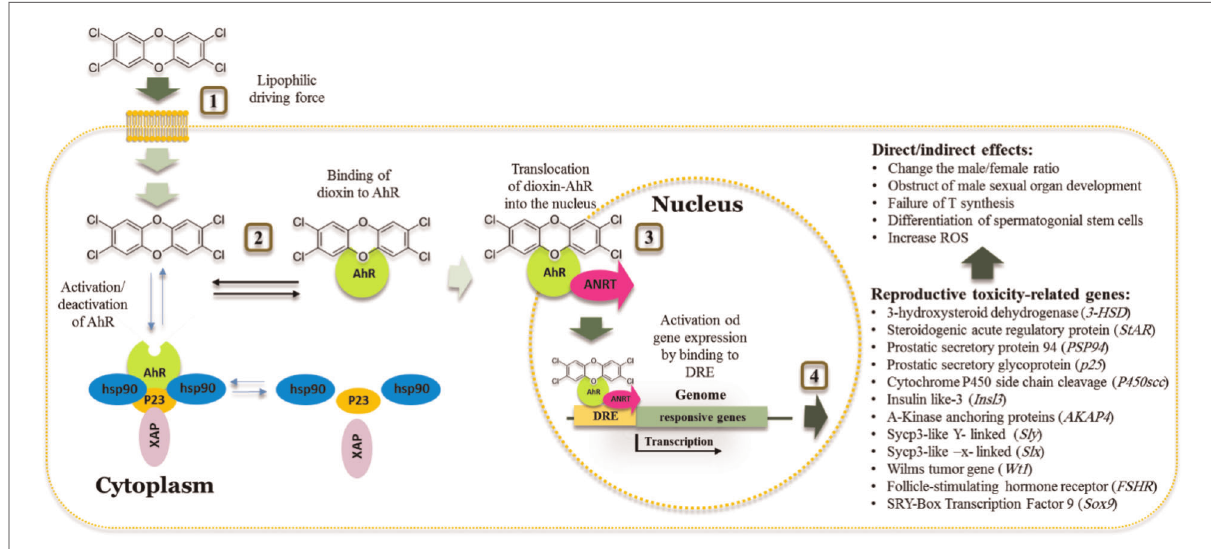
FIGURE 2 Schematic model of the action of dioxins in cell and aryl hydrocarbon receptor dependent toxic effect on Male reproductive system. 1 . Dioxins pass the membrane cell by a high lipophilic driving force. 2. Once inside, the cell activates the aryl hydrocarbon receptor (AhR) receptor that normally found inactivated by complexing with Hsp90, XAP and P23 proteins. 3. Binding of dioxin to AhR results in the release of other proteins. Translocation of dioxin/AhR into the nucleus occurred by dimerization of AhR with receptor nuclear translocator (ARNT). 4. The AhR-ARNT heterodimer binds to dioxin responsive element (DRE), activating the expression of certain isoforms of cyp1a and cyp1b genes resulting in a range of activities including detoxi fi cation of dioxins and spermatogenesis-related